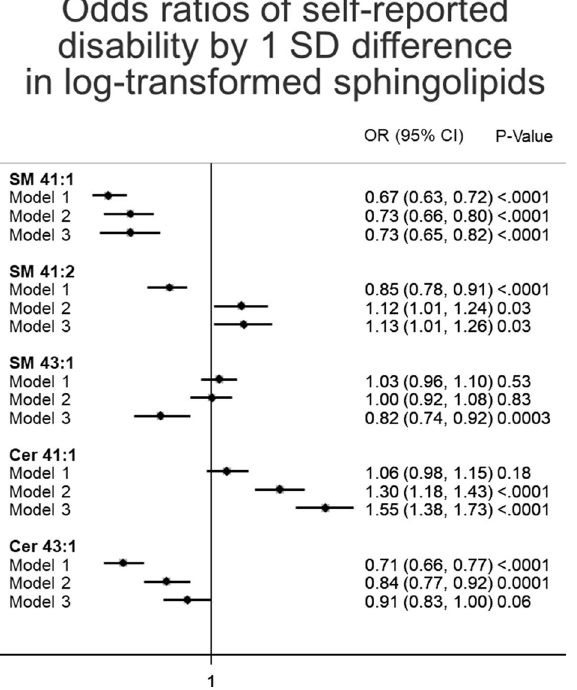
Figure 2. Odds ratios of self-reported disability by 1 SD difference in log-transformed sphingolipids, ARIC 2011–2017. The association of each metabolite with self-reported disability was estimated using logistic regression models, with the outcome modeled as either reporting disability or no disability. Odds ratios less than 1 indicate a protective effect. Number of individuals reporting disability was 103 (n = 359). SD standard deviation, OR odds ratio, CI confidence interval, SM sphingomyelins, Cer ceramides. Model 1: logistic regression adjusted for age, sex, race-site, and batch effects. Model 2: as model 1, plus additional adjustment for body mass index, diabetes status, hypertension status, use of lipid lowering medication, total cholesterol, Digit Symbol Substitution test z-score, and prevalent stroke at the ARIC visit 5. Model 3: as model 2, plus additional adjustment for education, presence of an APOE4 allele, Mini-mental state examination (MMSE) score, sports index, previous heart failure, previous coronary heart disease, CES depression score, HDL cholesterol, triglyceride levels, SF bodily pain score, current smoking status, and current drinking status.